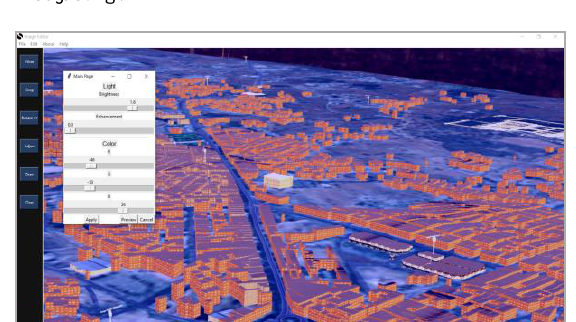
• Image app that lets the user do some basic editing from cropping, applying some filters, drawing, rotating, and adjusting.